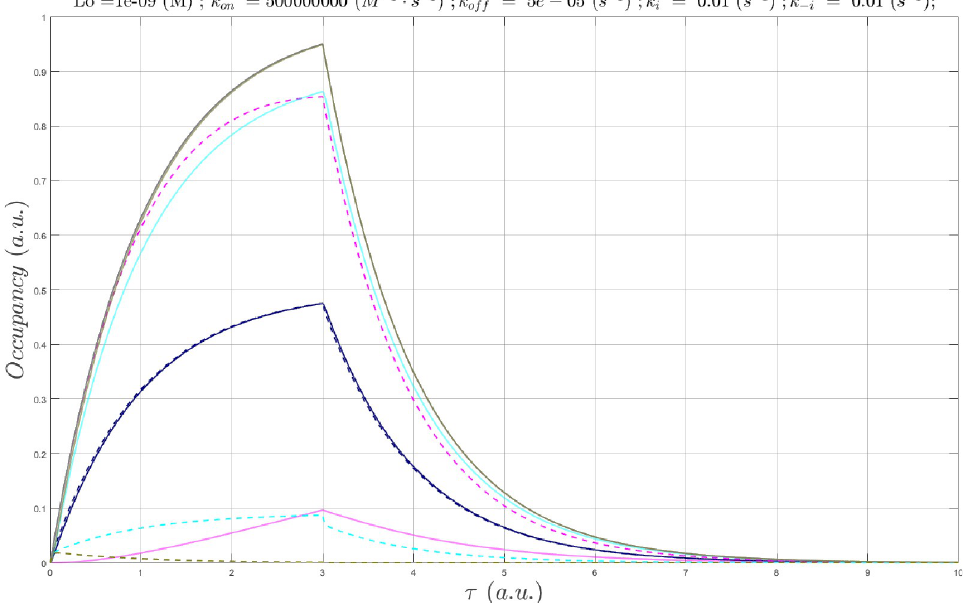
Fig 16. Plot of B total ( τ ) (gray), c ( τ ) at L 0 = k off / k on =1 nM and Λ = min ( k i = k − i = 1x10-2 s-1), in which k off and k on were sampled at 5x10 -1 s -1 /5x10 8 M -1 s -1 (blue), 5x10 -7 s -1 /5x10 5 M -1 s -1 (magenta), 5x10 -2 s -1 /5x10 8 M -1 s -1 (cyan), and 5x10 -5 s -1 /5x10 8 M -1 s -1 (olive) (solid lines), and B ( τ ) (dotted lines correspond to the c ( τ ) color scheme). c ( τ ) is unaffected by free slowing k off (magenta curve) when k on < k . However, when k on � k , c ( τ ) increases when k off is further slowed (e.g. on SS on SS 5x10 -1 s -1 ! 5x10 -2 s -1 (cyan curve) and 5x10 -1 s -1 ! 5x10 -5 s -1 (olive curve)).